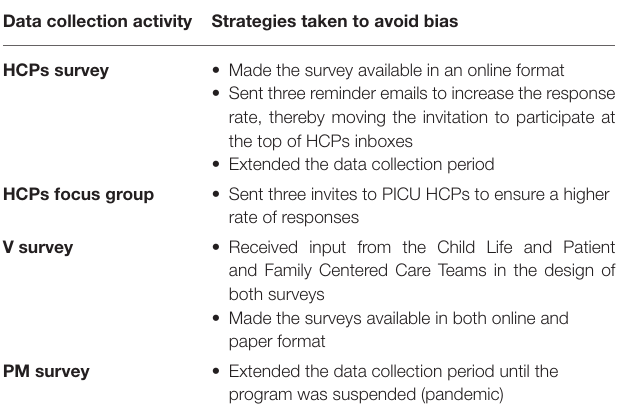
TABLE 1 | Data limitation activities and